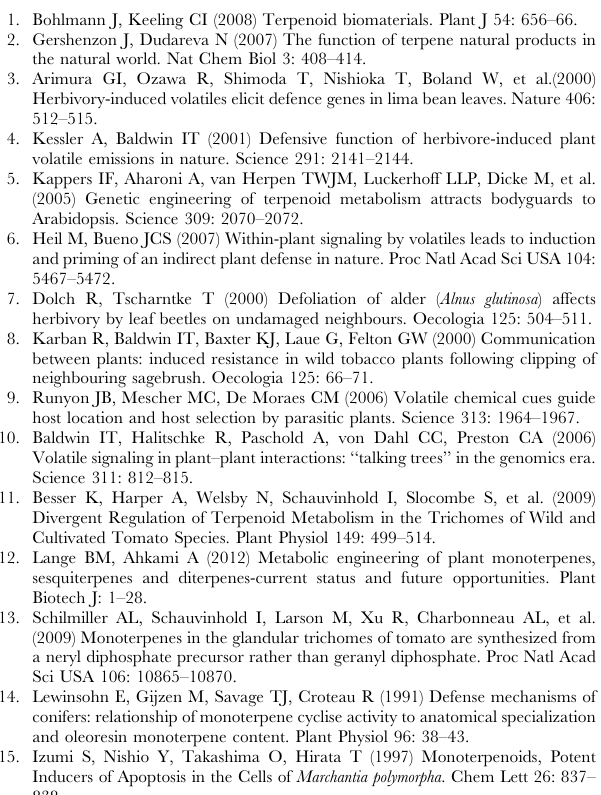
Figure S3 Closed environment used for the treatment of 45-days old tomato plantlets (A) and 15-days old seedlings (B). Table S1 GenBank accession numbers of ESTs. Table S2 List of geraniol-responsive tomato unigenes (contigs and singletons). Table S3 List of primers used for quantitative RT-PCR